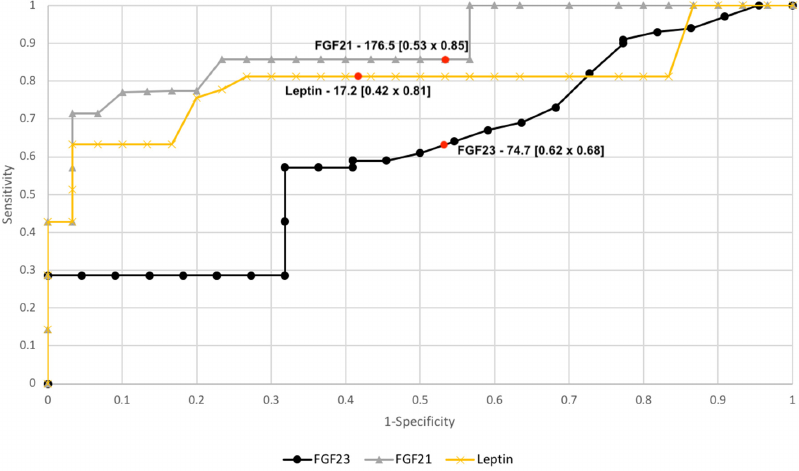
Figure 3. The receiver operating characteristic curves for proteins in endometrial cancer and benign endometrial changes.